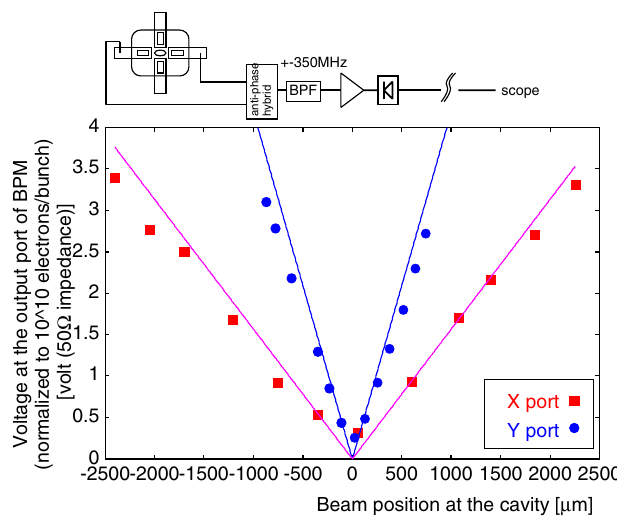
FIG. 8. (Color) The result of position sensitivity measurement. Signals from two opposite ports were combined with an anti- phase hybrid. It was measured with the simple electronics illustrated in the top. Sensitivity can be measured from the slope of the V shape. Lines are the expectation from the cavity